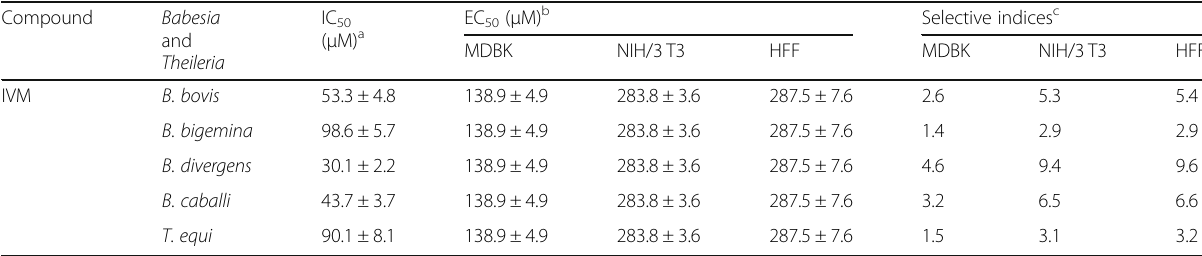
Table 1 IC 50 and selectivity index of IVM Compound